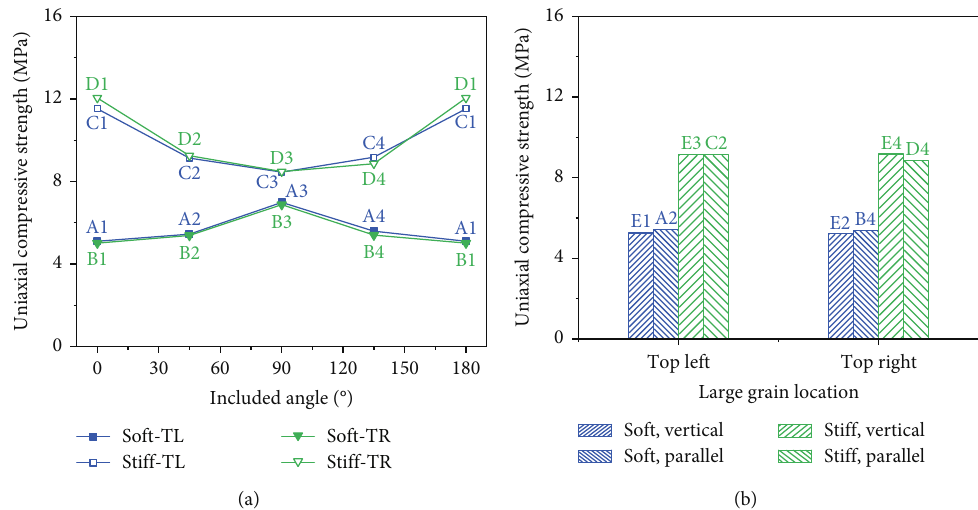
Figure 14: Uniaxial compressive strength (UCS) of the structures presented in Figure 13 with di ff erent (a) inclinations and (b) major axis positional relationship. The label “ soft/sti ff ” represents the structure mainly comprising the porous matrix or nonclayey minerals. The label “ vertical/parallel ” represents the major axis positional relationship between the large and ordinary inclusions. The labels on the data correspond to the sub fi gure labels in Figure